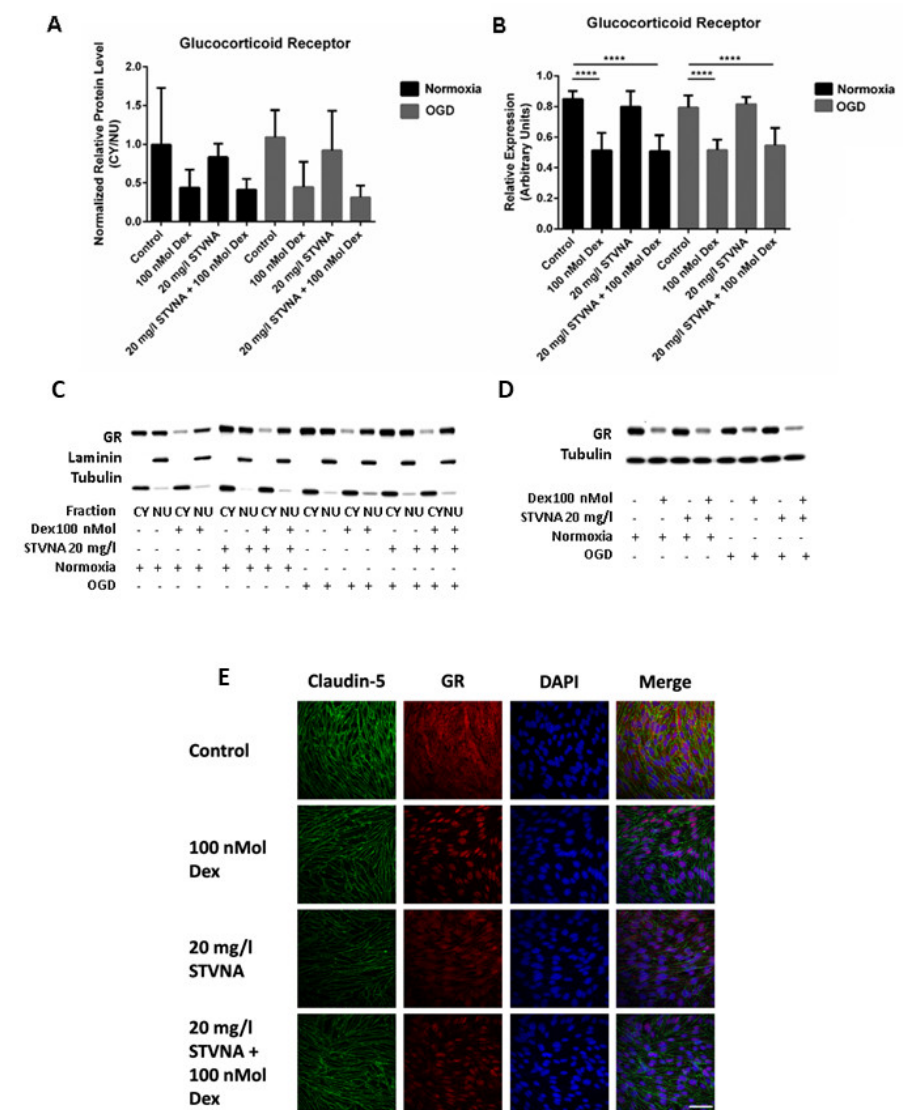
Figure 2. STVNA had no effects on transcriptional activation of GR. ( A ) Fractioned Western blot analysis of GR expression. Densitometric values were calculated relative to endogenous nuclear lamin A and cytoplasmic tubulin controls. CY = cytoplasmic fraction; NU = nuclear fraction. ( B ) Western blot of GR expression in whole cell lysates. **** p ≤ 0.0001. ( C , D ) Representatives blots of A and B. Blot shown is epresentative of n = 3 and n = 5 independent experiments for A and B, respectively. ( E ) Confocal immunofluorescence imaging of cells treated with STVNA post-OGD. GR= glu- cocorticoid receptor; nuclei stained with DAPI; staining of tight junctional protein claudin-5 served as a marker for cerebEND cells. Magnification = 60×, Scale bar = 50 µm. The GR is a ligand-activated transcription factor that controls gene function in many physiological processes. It binds to target sites within promoter regions of genes assem-